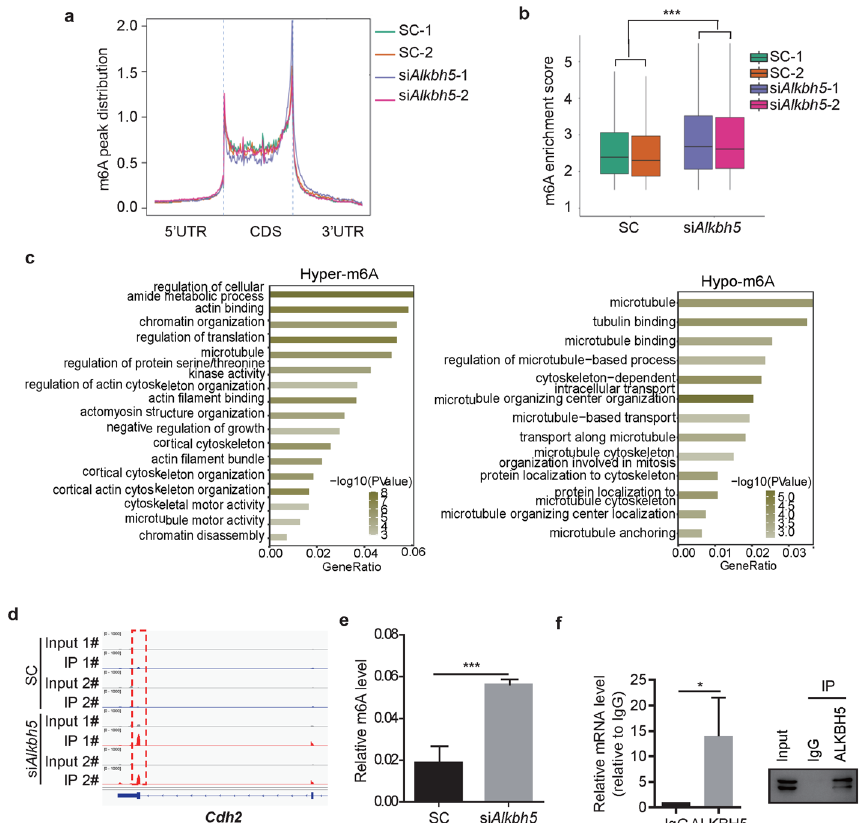
Fig. 4 Identification of Cdh2 mRNA as a substrate of ALKBH5 in the TM4 cell line. a Bioinformatic analysis for distribution of m 6 A peaks along the whole transcript. b Bioinformatic analysis for changes in the m 6 A enrichment score. c Biological process analysis in Gene Ontology of the genes encoded by the hypermethylated or hypomethylated RNAs. d The intergrative Genomics Viewer (IGV) plots showing the m 6 A peak (marked by red dashed box) of Cdh2 mRNA in TM4 cells transfected with scramble siRNA (SC) or Alkbh5 ‑targeting siRNAs (si Alkbh5 ). e Results of m 6 A‑IP qPCR showing the relative m 6 A level of Cdh2 mRNA. f Results of RIP–qPCR detecting the interaction between ALKBH5 protein and Cdh2 mRNA. Western blot analysis of the immunoprecipitated proteins is shown in the right panel. * P <